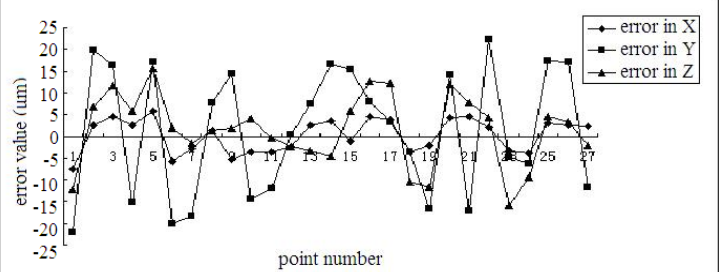
Figure 7. Variation of error caused by Abbe error.